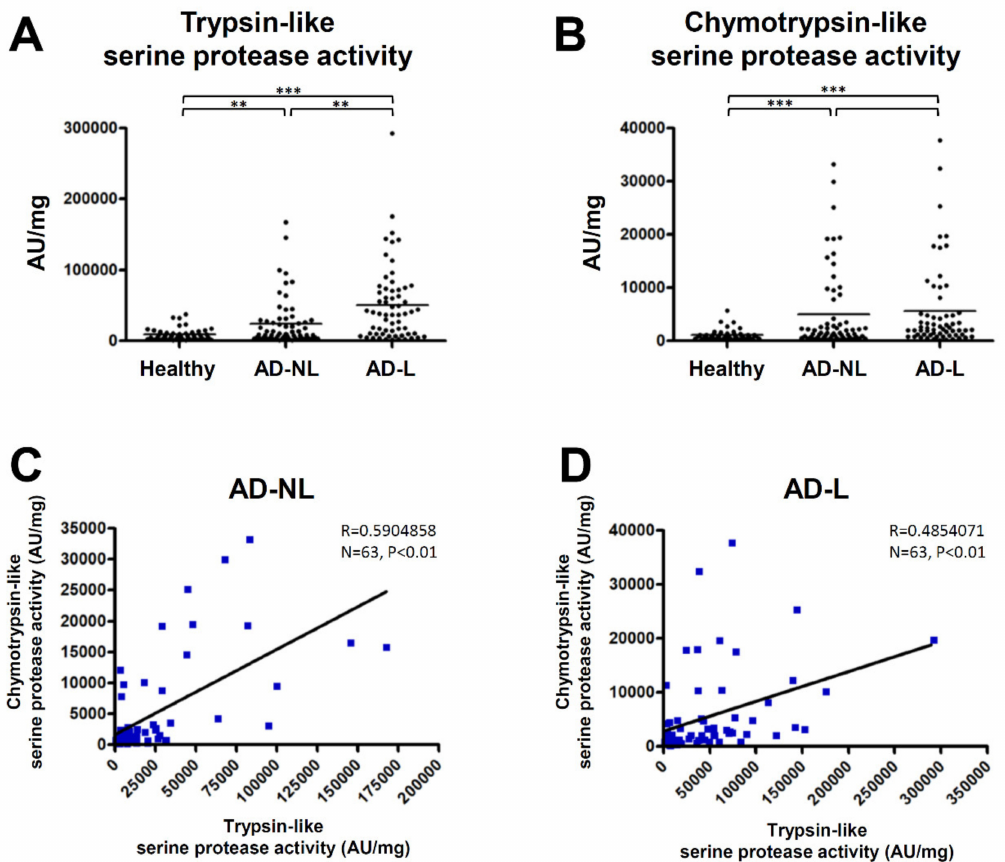
Figure 1. Serine protease activity in the stratum corneum (SC) of atopic dermatitis (AD) patients was increased in both non-lesions and lesions. ( A , B ) Trypsin- and chymotrypsin-like serine protease activity in the SC of normal healthy volunteers ( n = 46) and both non-lesions (AD-NL) and lesions (AD-L) of AD patients ( n = 63) were measured. ** p < 0.01, *** p < 0.001. ( C , D ) The correlations between trypsin- and chymotrypsin-like serine protease activity in the non-lesions and lesions of AD patients were analyzed by Spearman’s rank correlation coe ffi